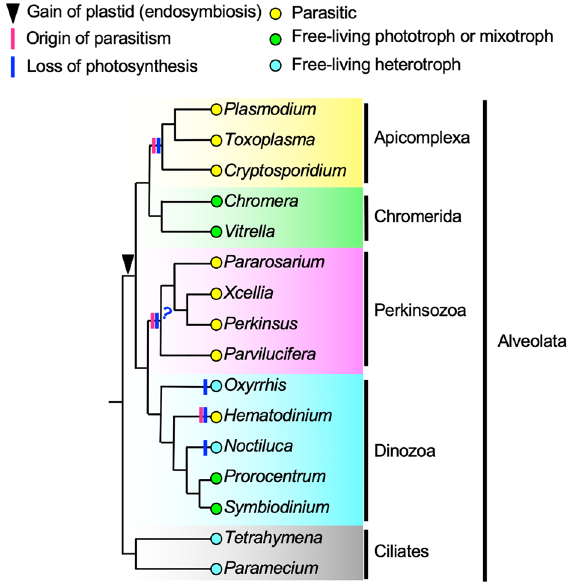
Figure 1. Simplified phylogenic tree of the Alveolata and the evolutionary background of its complicated lifestyle. Traditionally, Alveolata was divided into three main groups: ciliates, Dinozoa, and Apicomplexa. Acquisition of photosynthesis (the black triangle) by secondary endosymbiosis occurred in the common ancestor of Dinozoa, Perkinsozoa, Chromerida, and Apicomplexa. However, loss of photosynthetic capacity (shown by the blue bars on the tree) and acquisition of parasitism (shown by the magenta bars on the tree) independently occurred multiple times. Thus, there is a complicated mixture of free-living and parasitic protists in Alveolata. Cellular and molecular biological studies are intensive in Plasmodium and Toxoplasma , for which gene transfection methods have been established. Perkinsus is also expected to become a new model organism closely related to Apicomplexa, as progress is being made in gene transfection technology. The question mark at the base of Perkinsozoa indicates uncertainty about the timing of the loss of photosynthesis.